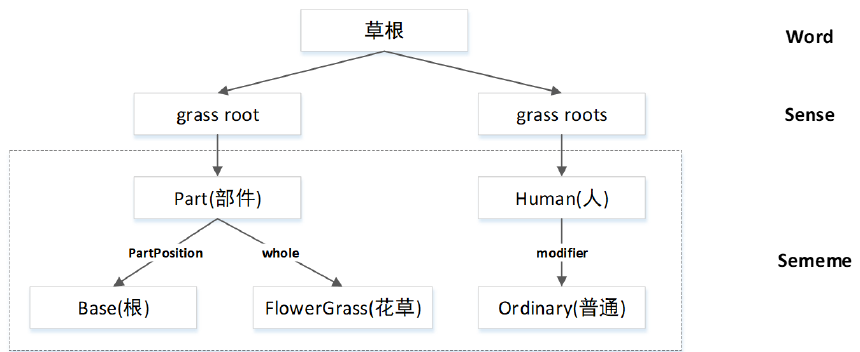
Figure 1. The sememes of Word “ 草根 ” in a commonsense database.